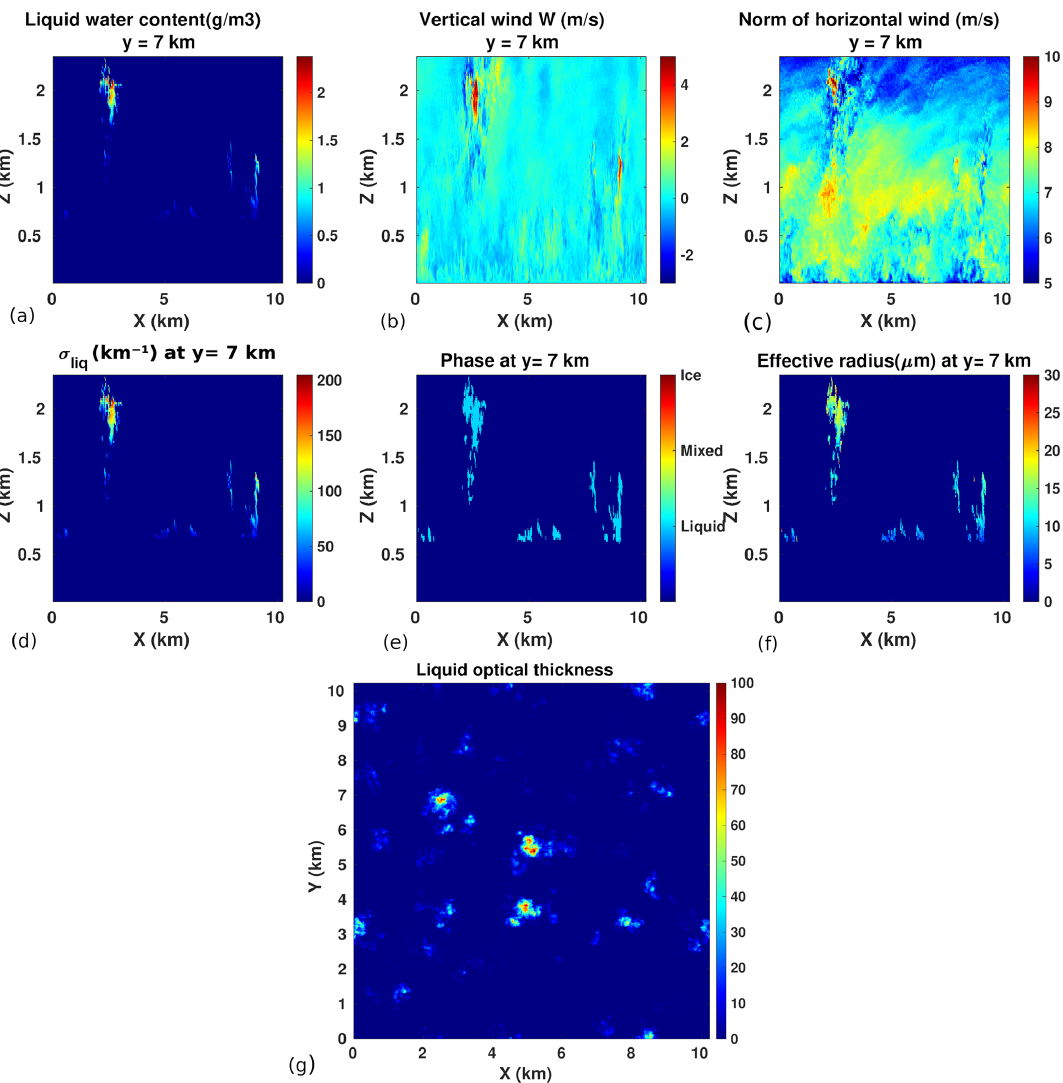
Figure 4. Trade wind cumulus physical properties. (a, b, c) Vertical section for y = 7km, from left: liquid water content, vertical, and horizontal wind components, respectively. (d, e, f) Vertical section ( y = 7km), from left: liquid extinction coefficient, cloud phase, and effective radius. Panel (g) : cloud liquid optical